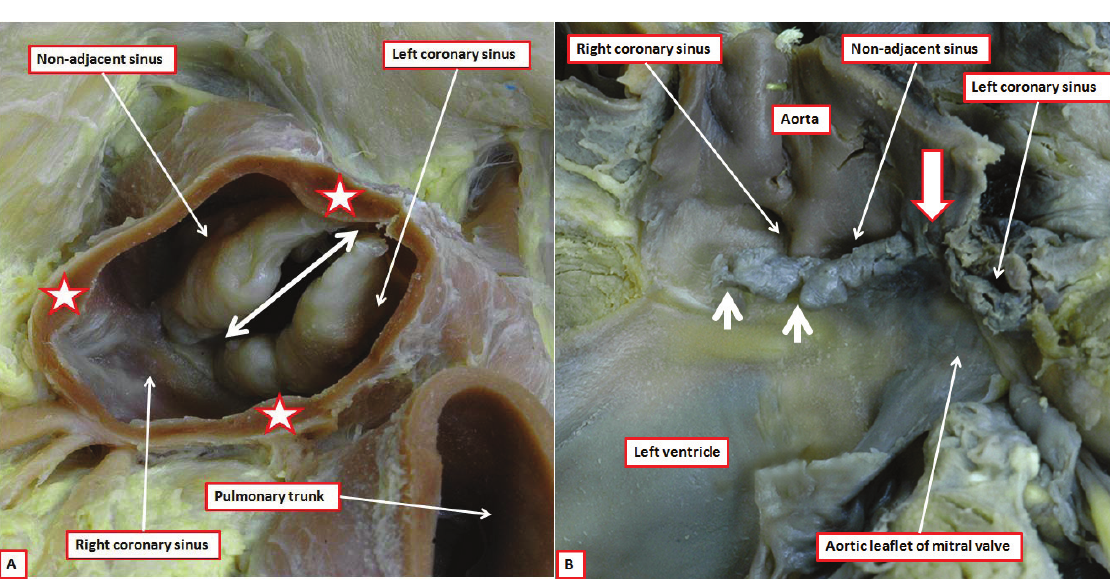
Figure 14. The images show grossly dysplastic aortic valves that produced critical stenosis in early childhood. Panel ( A ) shows a valve with a solitary zone of apposition between the dysplastic remnants of the leaflets (double headed white arrow). It is possible to recognize three thickenings at the sinutubular junction (stars). Opening the valve (panel ( B )) reveals that the leaflets are attached in annular fashion, with two rudimentary interleaflet triangles (white arrows) corresponding to the thickenings at the sinutubular junction. This is the so-called unicuspid and unicommissural variant, with the zone of apposition at the apex of the solitary interleaflet triangle pointing back to the aortic leaflet of the mitral valve (white arrow with red borders). In the heart shown in panel ( C ), two zones of apposition, at the apex of dual interleaflet triangles, extend to the sinutubular junction (white arrows with red borders). There is a raphe in one of the remaining leaflets. This is a bicuspid valve, with the conjoined leaflet formed from the right coronary and non-adjacent leaflets. Note the presence of an additional subvalvar fibrous shelf, which accentuates the valvar